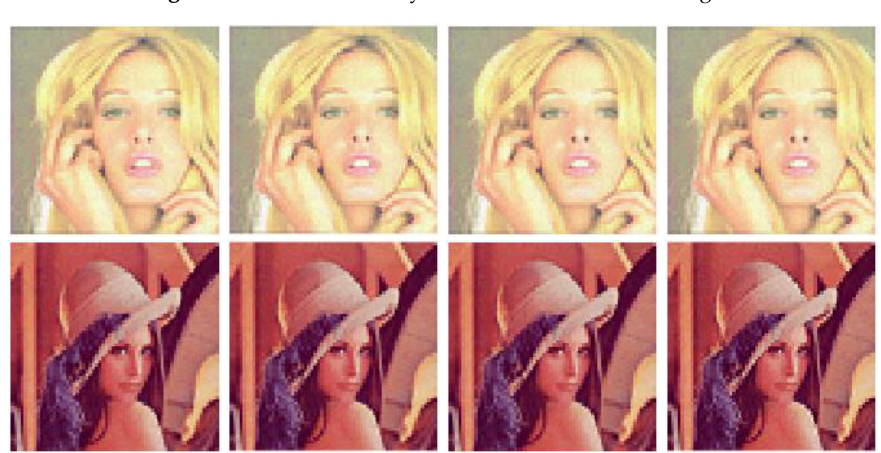
Figure 5. Restored images by DF-LSTT ( left column ), CGD ( left middle column ), SGCS ( right middle column ), and MFRM ( right column